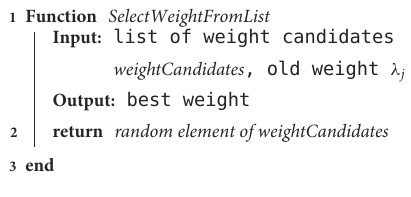
Algorithm 4. Select weight from candidate